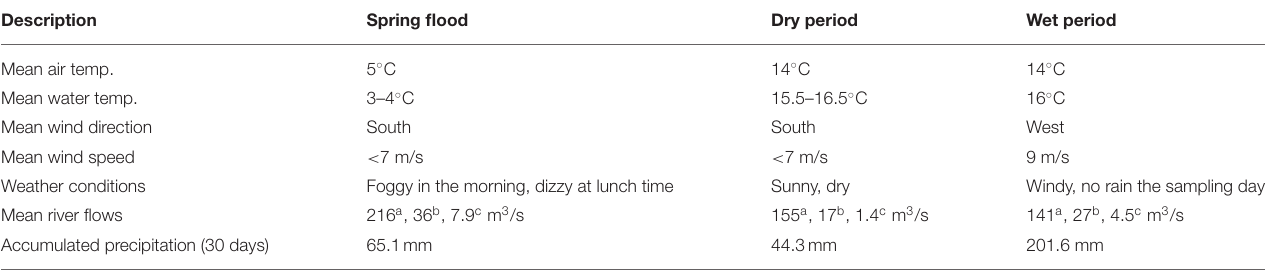
TABLE 2 | Weather conditions during each of the sampling campaigns. Description Spring flood Dry period Wet period Mean air temp. Mean water